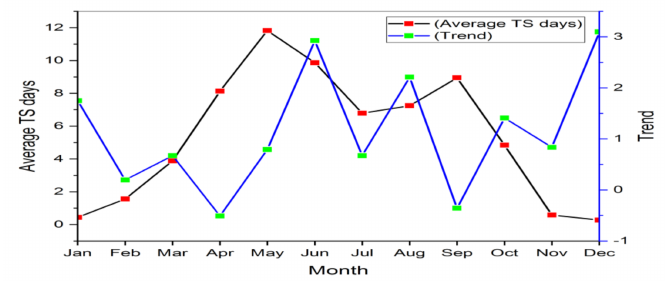
Figure 2. Average monthly thunderstorm (TS) days in Bangladesh during 1975–2016.